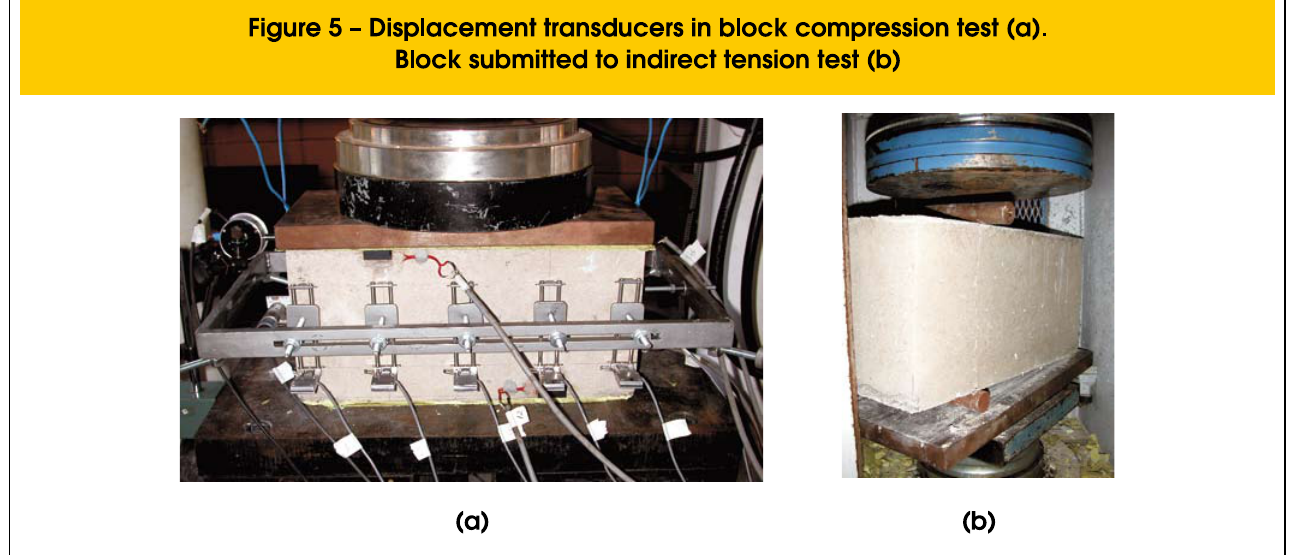
Figure 4. The front view of displacement transducers is represent -